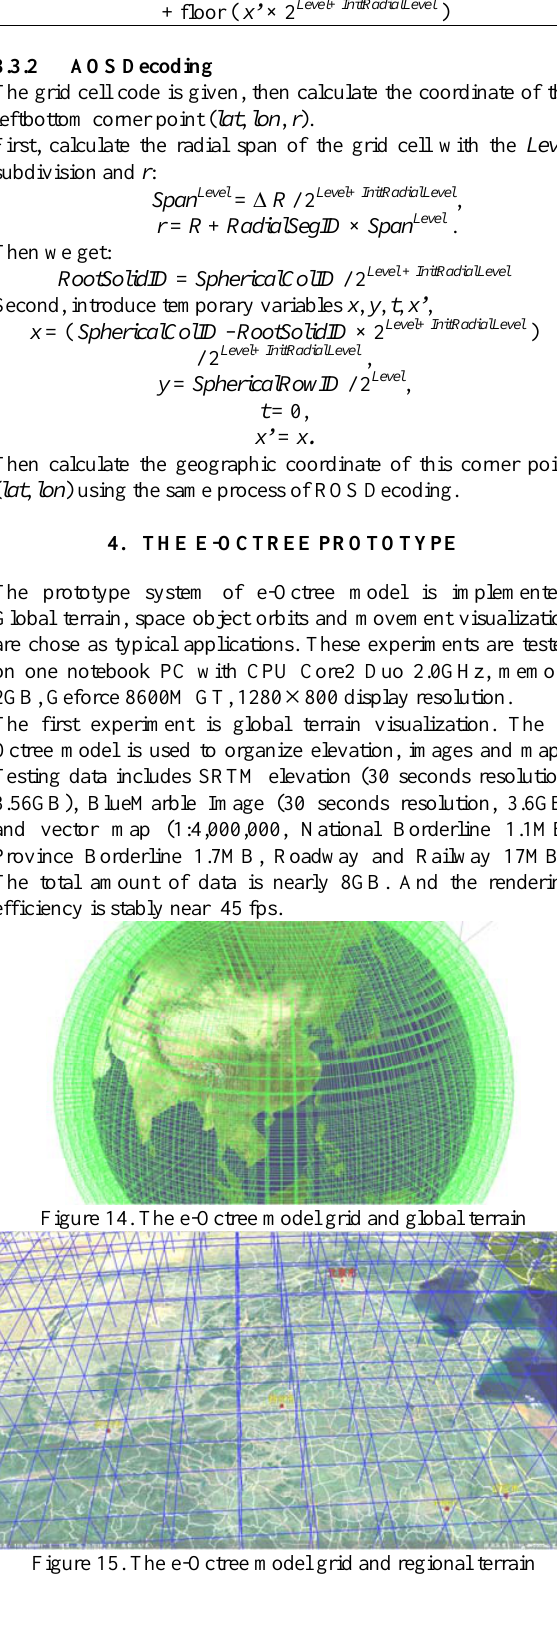
Figure 16. The e-Octree model grid and circular orbit